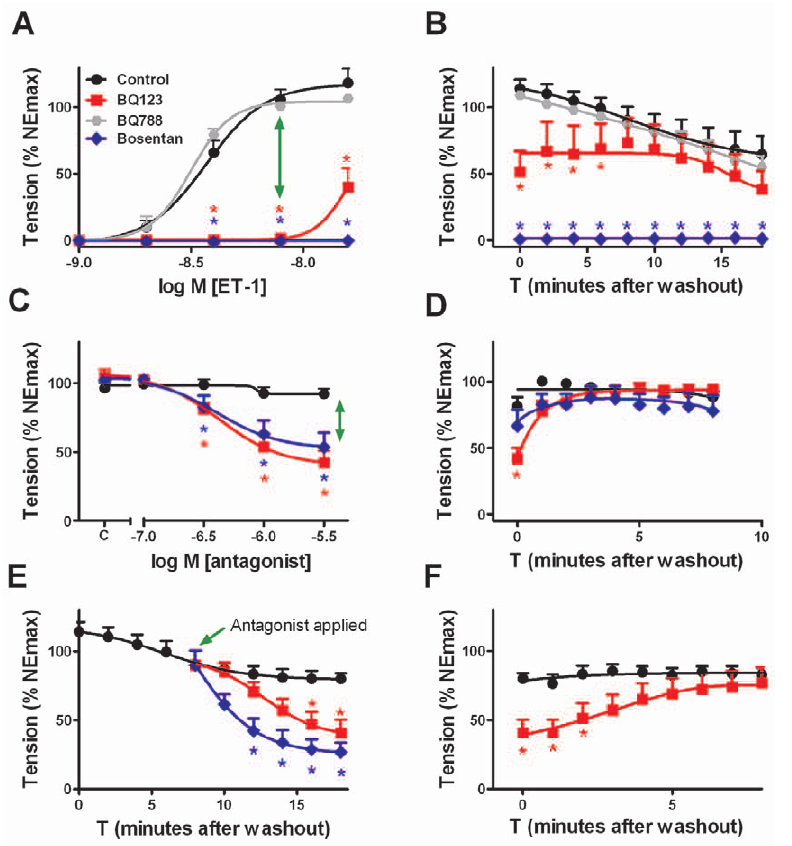
Figure 1. Partial and reversible reversing effect of ET-receptor antagonists on arterial contractile responses to ET-1 and their persistence. Isolated rat mesenteric resistance arteries were studied after treatment with capsaicin and in continuous presence of L-NAME (100 m M) and indomethacin (10 m M). A, responses to 0.25–16 nM ET-1 in absence (black) and presence of BQ123 (1 m M, red), BQ788 (1 m M, grey) or bosentan (3 m M in presence of 1 m M BQ788, blue). BQ123 and bosentan prevented responses to up to 8 nM ET-1. B, vasomotor tone after removal of free agonist and antagonist. C, effects of BQ123 and bosentan (0.1–3.0 m M) in the presence of 8 nM ET-1. D, vasomotor tone after removal of free agonist and antagonist. E, effect of BQ123 (1 m M) and bosentan (3 m M) on contractile responses initiated by 8 nM ET-1 that persisted in absence of the peptide. F, vasomotor tone after removal of free antagonist. n=6–20. *, P , 0.05 vs. control.